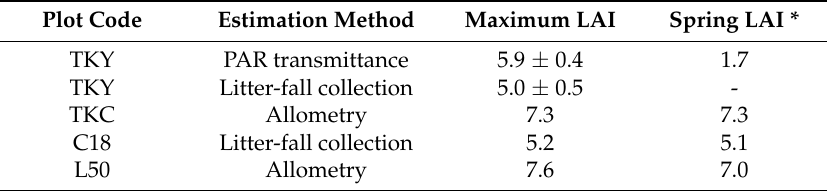
Table 5. Estimation of in situ LAI at the four study